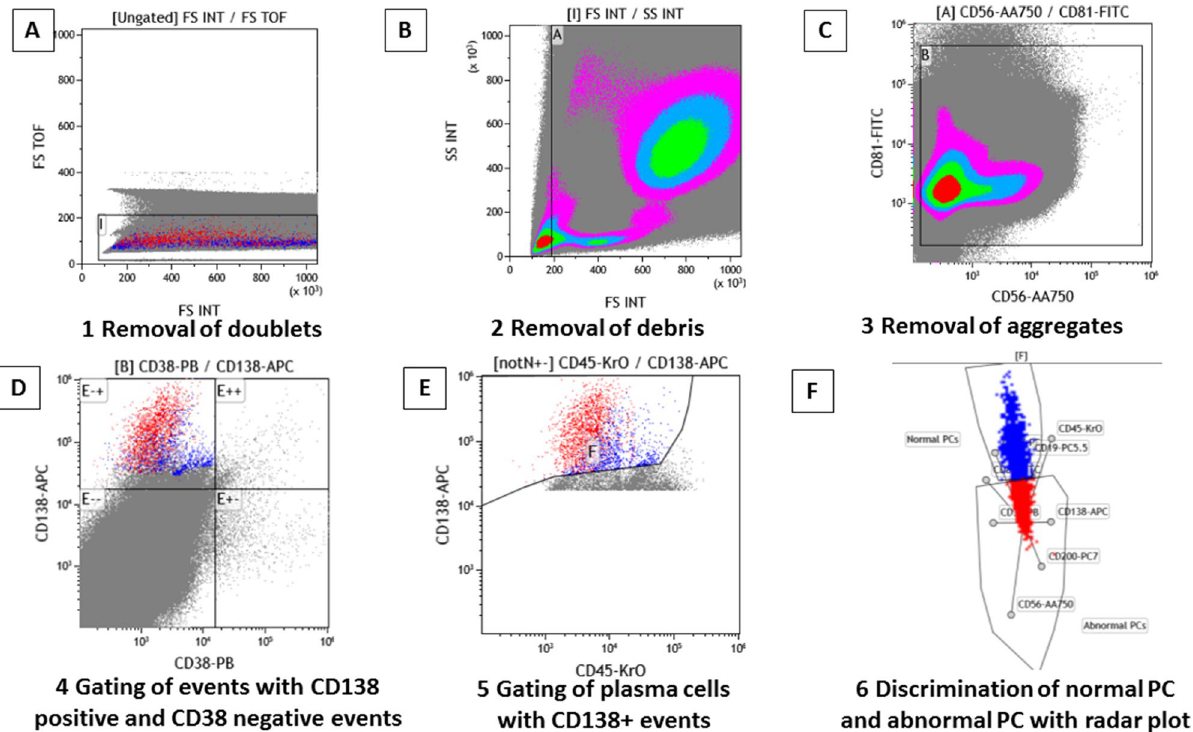
Figure 2. Overview of the gating strategy of plasma cells and discrimination of normal and abnormal plasma cells with radar plot by DuraClone method in patients who received anti-CD38 antibody. Light scatter characteristics are used to exclude doublets with high time of flight (TOF) ( A ), debris with lower scatter peak than lymphocytes ( B ) and aggregates with high fluorescent events with CD81-FITC and CD56-APC-A750 ( C ). PCs are captured by gating CD138 + CD38 − events ( D ). PCs are selected with CD138 high events using CD45 ( E ) Abnormal PCs are detected with radar plot ( F ). Red dots: myeloma cells, Blue dots: normal plasma cells. FS TOF forward scatter time of flight, FS INT forward scatter intensity, SS INT side scatter